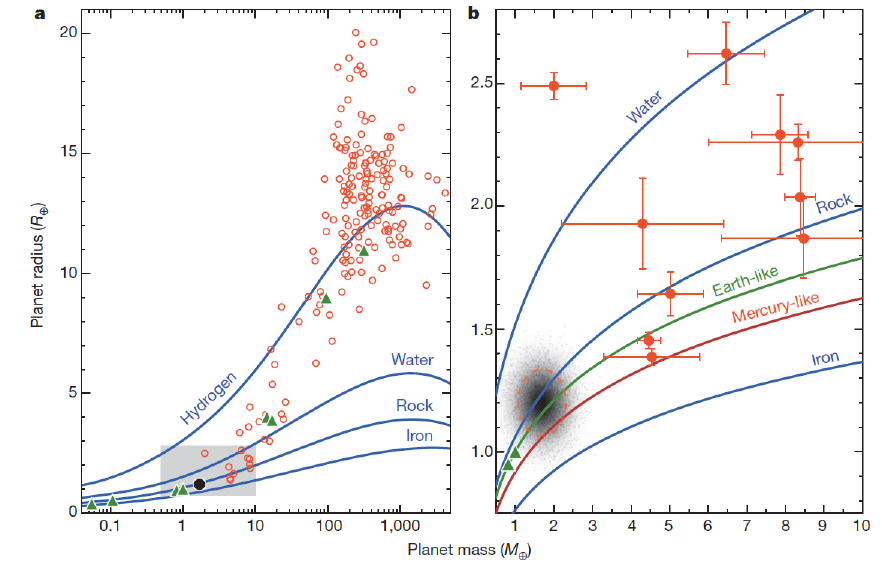
Figure 9. Mass-radius relationship for all well-characterized exoplanets. Triangles are for Solar System planets. The left-hand panel shows the full range of exoplanet radii and masses and illustrates that many close-in gas giants have inflated radii. The right-hand panel is for exoplanets with masses and radii similar to that of the Earth. It illustrates a degeneracy in that planets of different masses and compositions can have similar radii. It also illustrates that we have found exoplanets with a wide range of different compositions. (Figure from